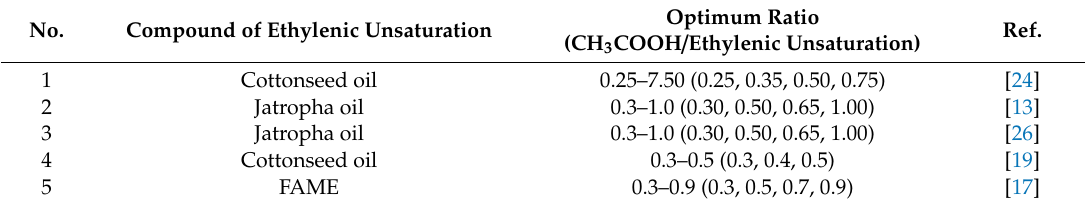
Table 3. Ratio of acetic acid to ethylene unsaturated carbon.